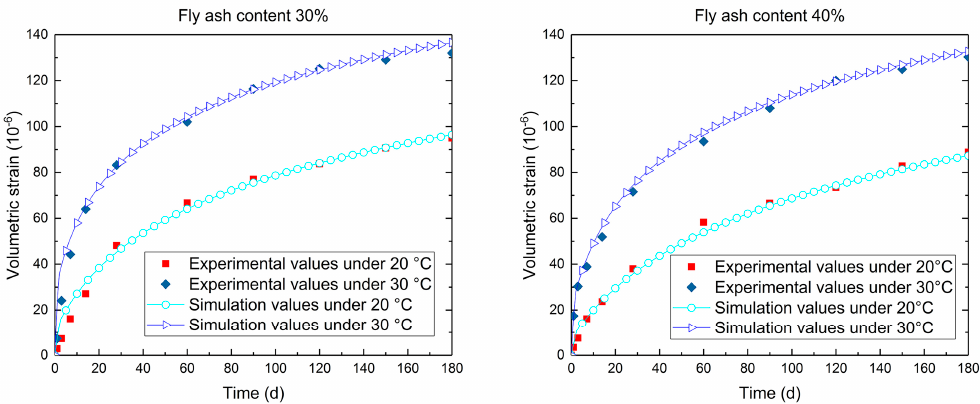
Figure 2. Comparison of the simulation and experimental values of the autogenous volumetric strain of magnesium oxide concrete with various curing temperatures (fly ash content 30% and 40%).